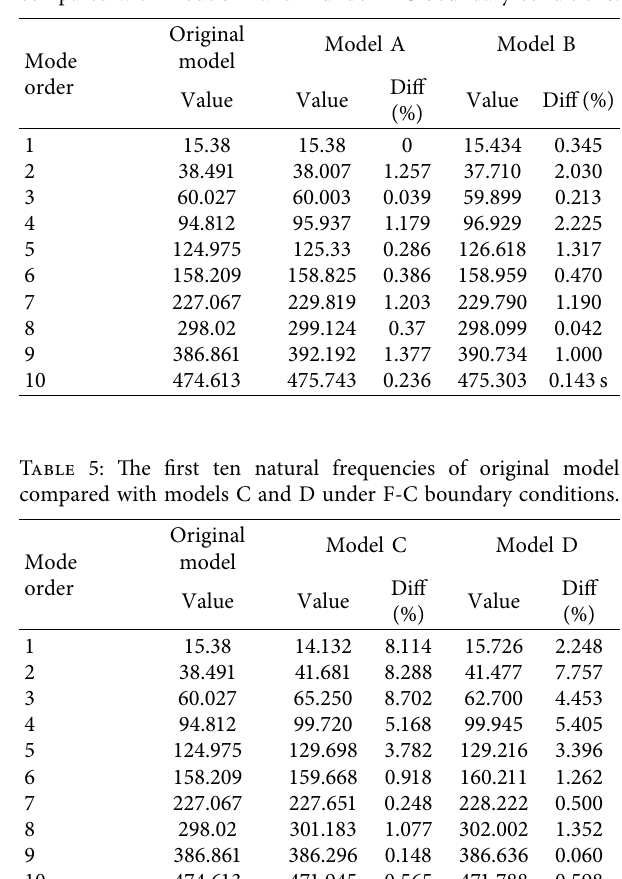
Table 4: The first ten natural frequencies of original model compared with models A and B under F-C boundary conditions.